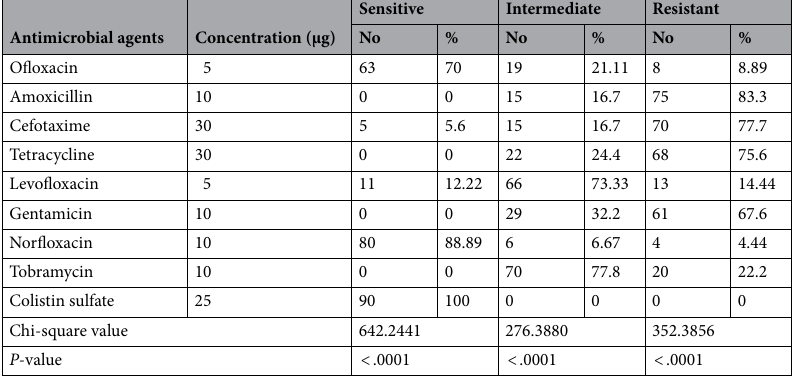
Table 4. Antimicrobial resistance profiles of P. aeruginosa strains ( n = 90 ) retrieved from naturally infected O. niloticus and C. gariepinus .